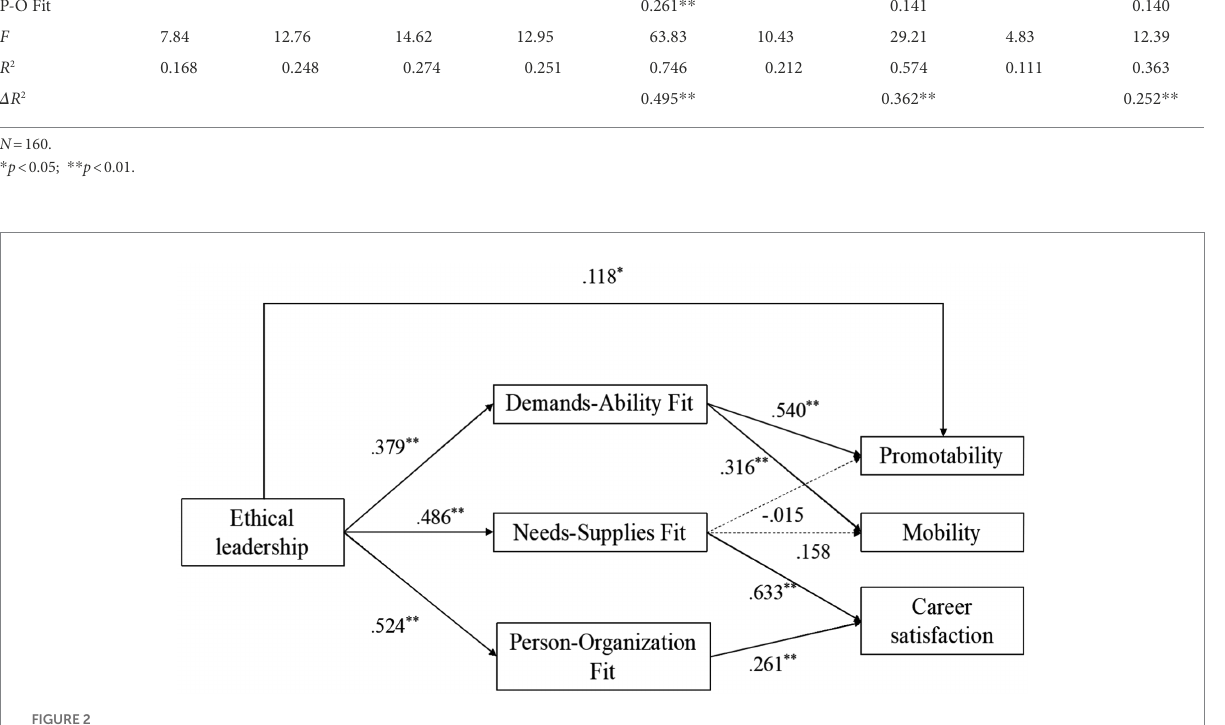
FIGURE 2 Results of hypotheses